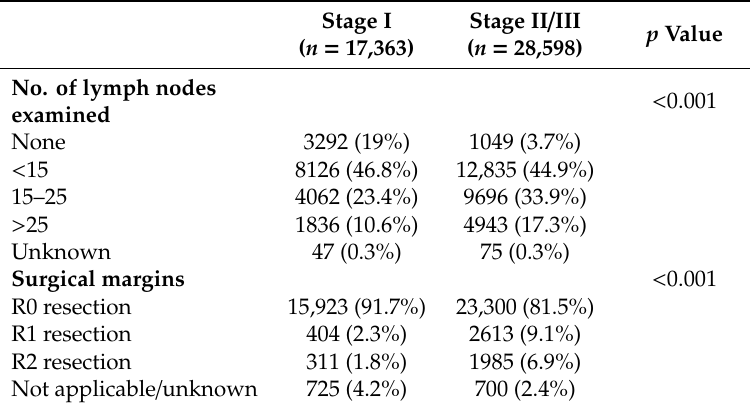
Table 2. Surgical Variables Examined for Stages I and II / III, n = 45,961.